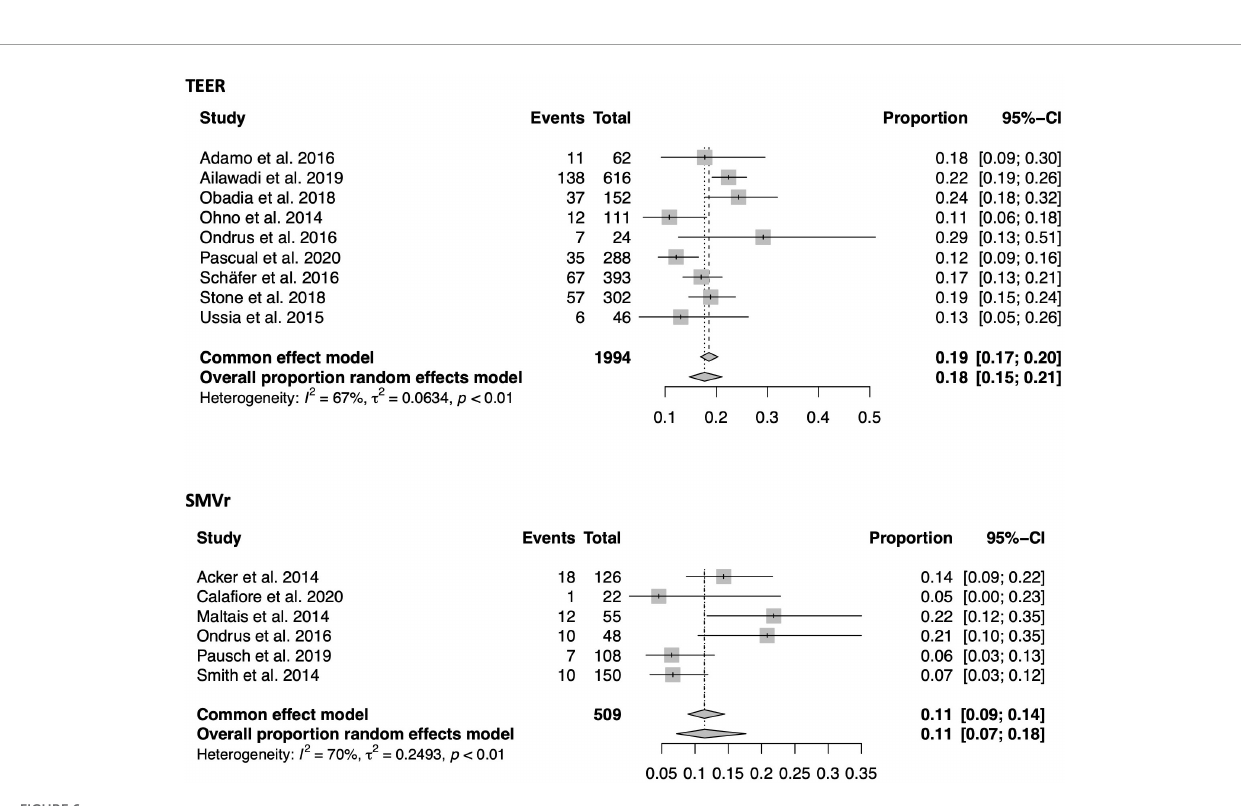
FIGURE6 Forrest plots of the comparison between TEER and SMVr for 1-year mortality. TEER, transcatheter edge-to-edge repair; SMVr, surgical mitral valve